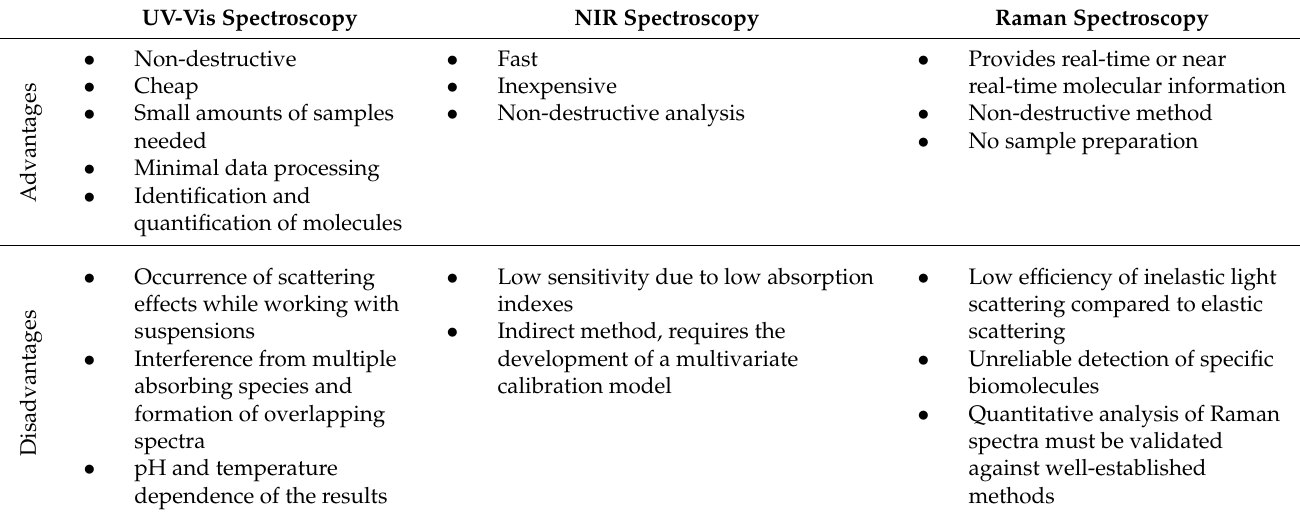
Table 1. The most important advantages and disadvantages of selected spectroscopy